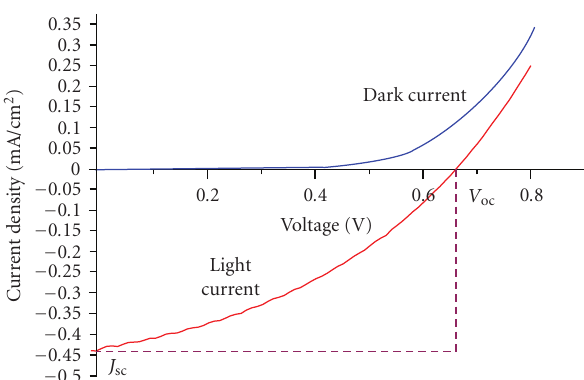
Figure 10: Conversion e ffi ciency measurement of the proposed